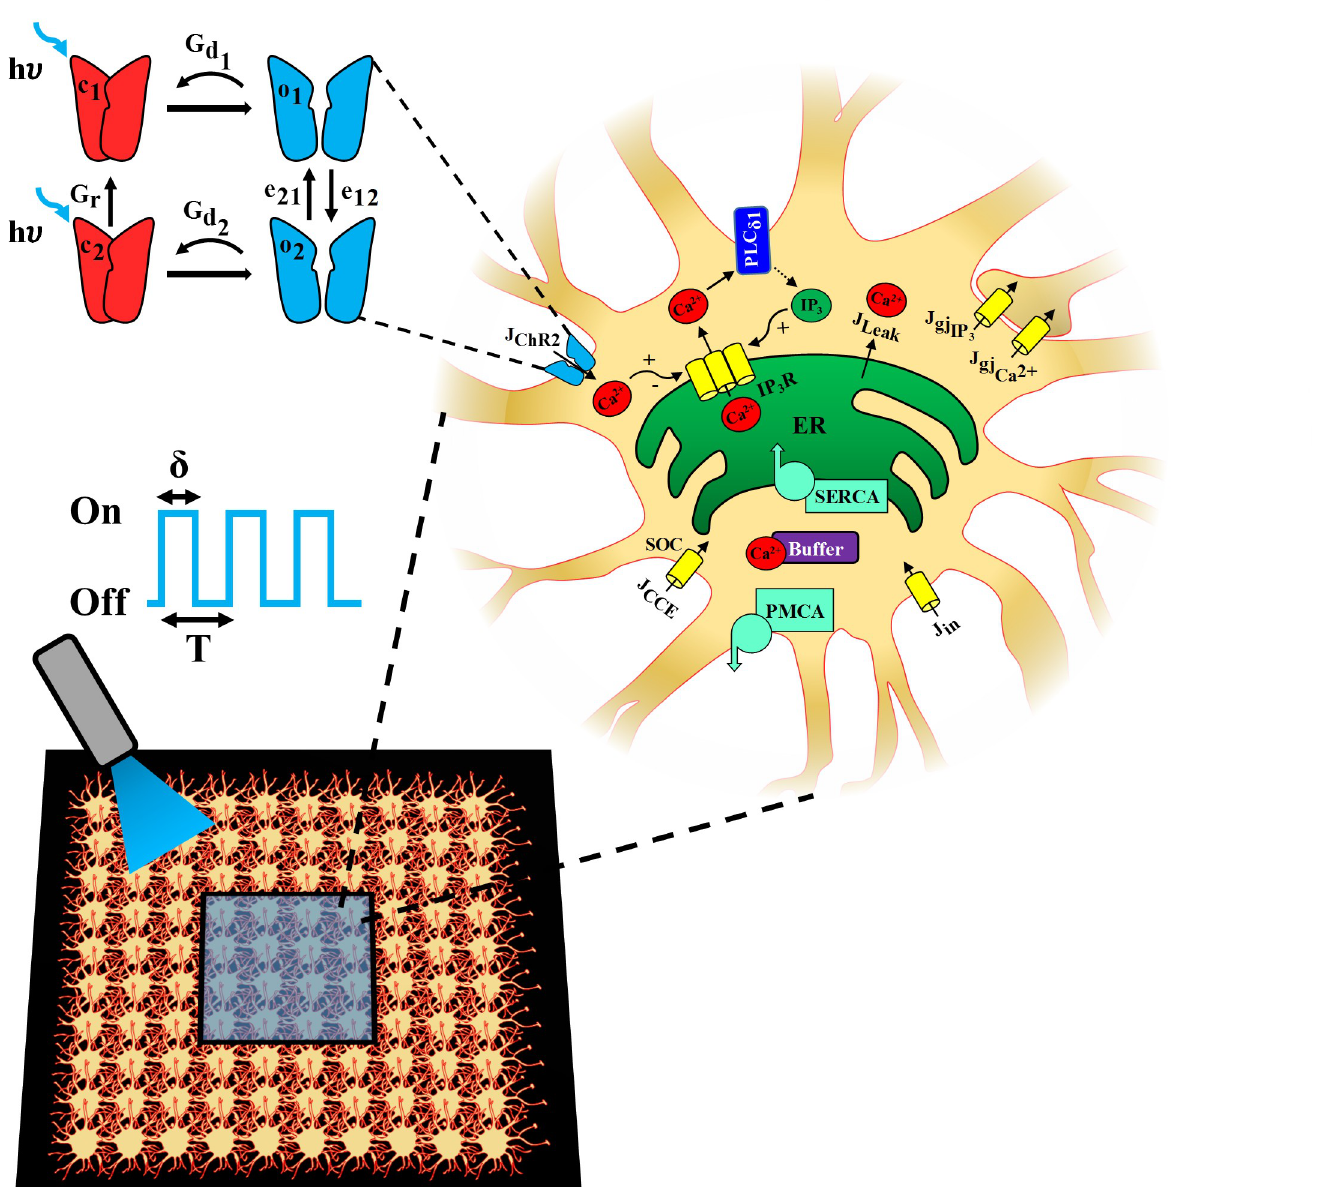
Fig 1. Schematic of the biophysical model. A model for a ChR2-expressing astrocyte is presented, accounting for: 1) Ca 2+ release from the endoplasmic reticulum (ER) into the cytosol via the IP 3 R clusters, 2) Phospholipase-C δ 1 (PLC δ 1 ) mediated production of IP 3, 3) capacitive calcium entry (CCE) via the store operated calcium channel (SOC), 4) passive leak from the ER to the cytosol (J leak ), 5) replenishment of ER stores via sarco(endo)plasmic reticulum Ca 2+ -ATPase (SERCA) pump, 6) extrusion of Ca 2+ by plasma membrane Ca 2+ ATPase (PMCA) pump into the extracellular (EC) space, 7) passive leak (J in ) into the cytosol from the EC space, and 8) Ca 2+ buffering by endogenous buffer proteins. In astrocytic network simulations (bottom panel), each cell is connected to its neighboring cells though Ca 2+ and IP 3 permeable gap junctions, indicated as J and J , respectively, and a central region (blue shaded box) is stimulated with light. A 4-state model gj Ca 2 þ gj IP 3 [closed states (c 1 and c 2 ) in red and open states (o 1 and o 2 ) in blue] is used to represent ChR2 gating dynamics. The blue light ( λ = 470 nm) stimulation paradigm used to open ChR2, leading to a Ca 2+ influx (J ChR2 ), is characterized by pulse period (T) and pulse width ( δ ). temporal kinetics of conformational changes of ChR2 following light stimulation. p denotes the vector of model parameters summarized in Table 1. Components of the f vector, i.e., the drift rate function, contain deterministic equations of the single cell model and are described